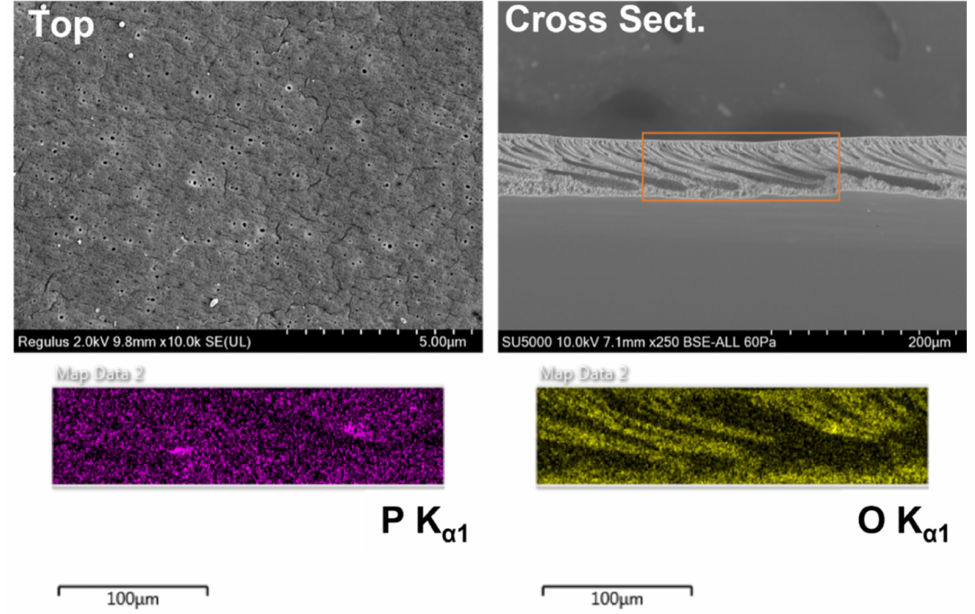
Figure 6. SEM-EDS images of 10 wt% PVDF- g -EGMP membranes cast without glycerol. Phosphorus (purple) and oxygen (yellow) distributions are shown for the region highlighted in the cross-sectional image. Average pore diameter was measured to be 0.098 ± 0.027 µ m.